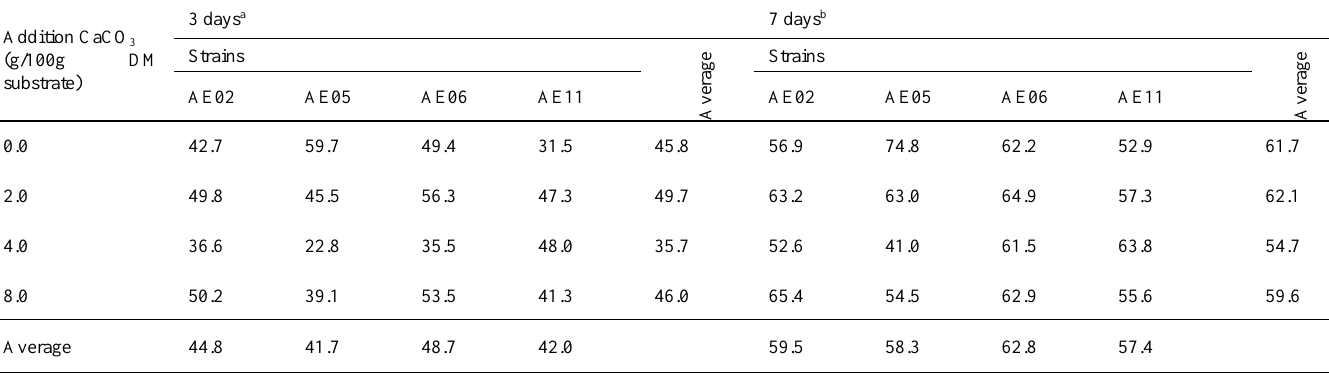
Table 4. Influence of addition of CaCO 3 on storability of fruiting bodies [%]. Fruiting bodies weight loss after 3 and 7 days of storage in cold room at 2 to 4°.